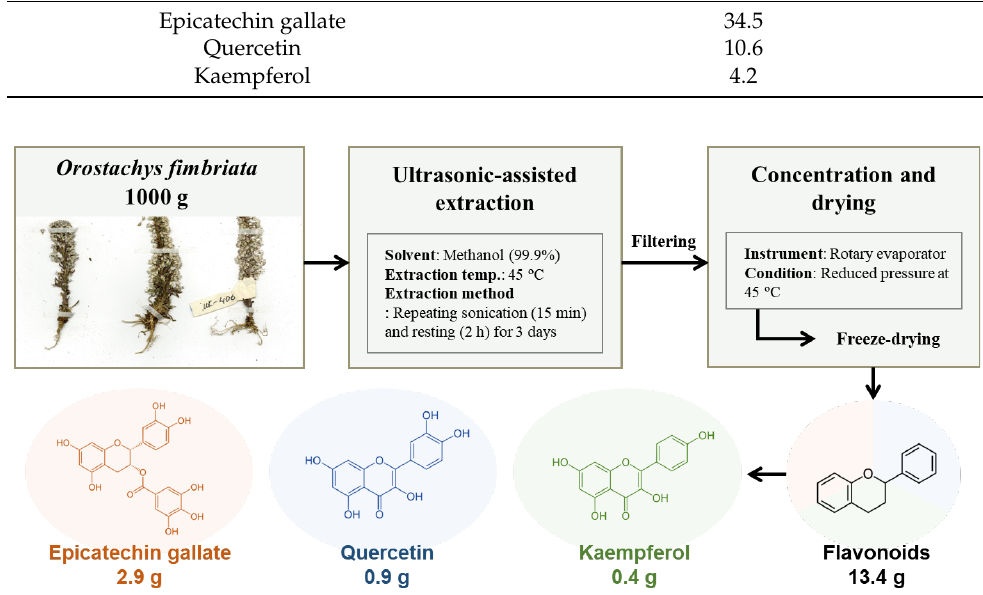
Figure 5. Mass balance of overall process for flavonoid recovery from 1000 g (dry basis) of Orostachys fimbriata